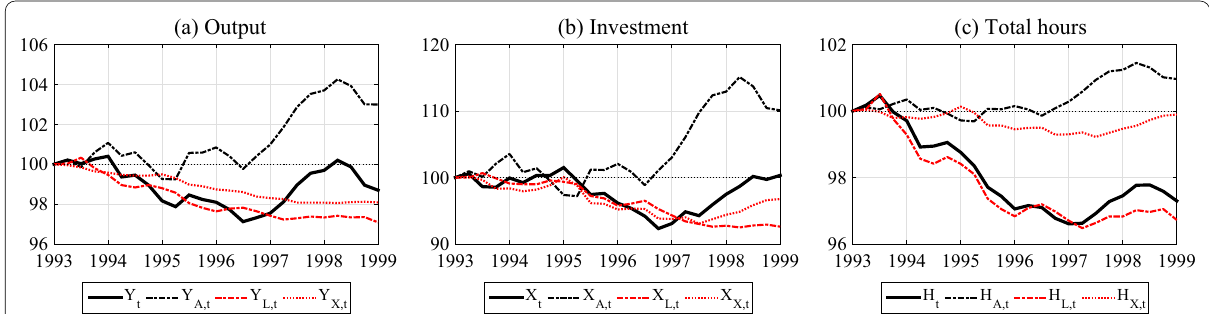
Fig. 15 Robustness: The 1993Q1–1999Q1 period for ν = 2 . The subscripts A , L , X denote the efficiency-, labour-, and investment-wedge-alone components of output Y t , investment X t , or total hours H t